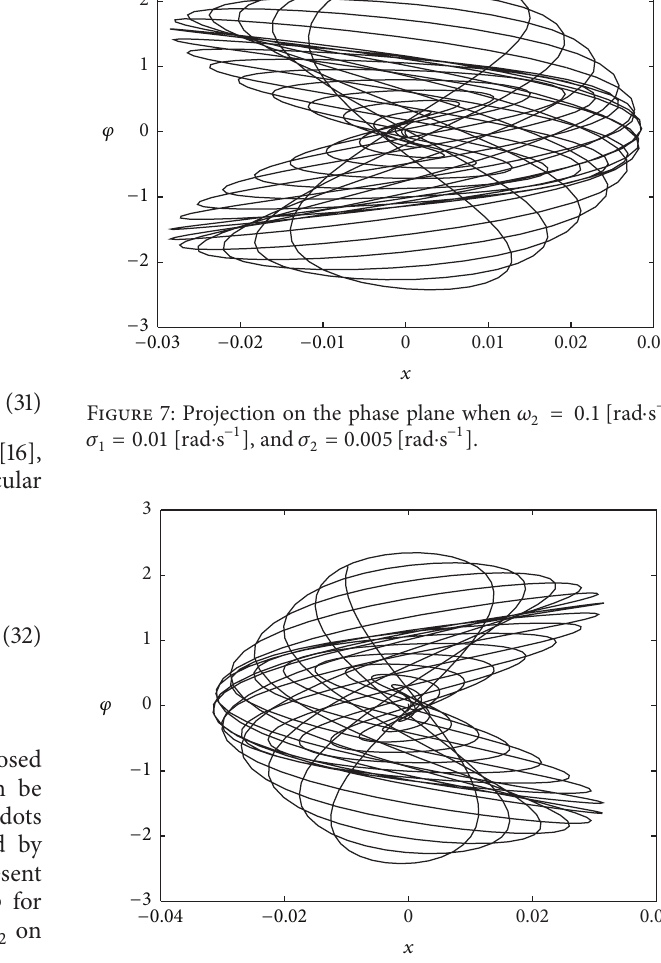
Figure 8: Projection on the phase plane when 𝜔 2 = 0.1 [rad ⋅ s −1 ], 𝜎